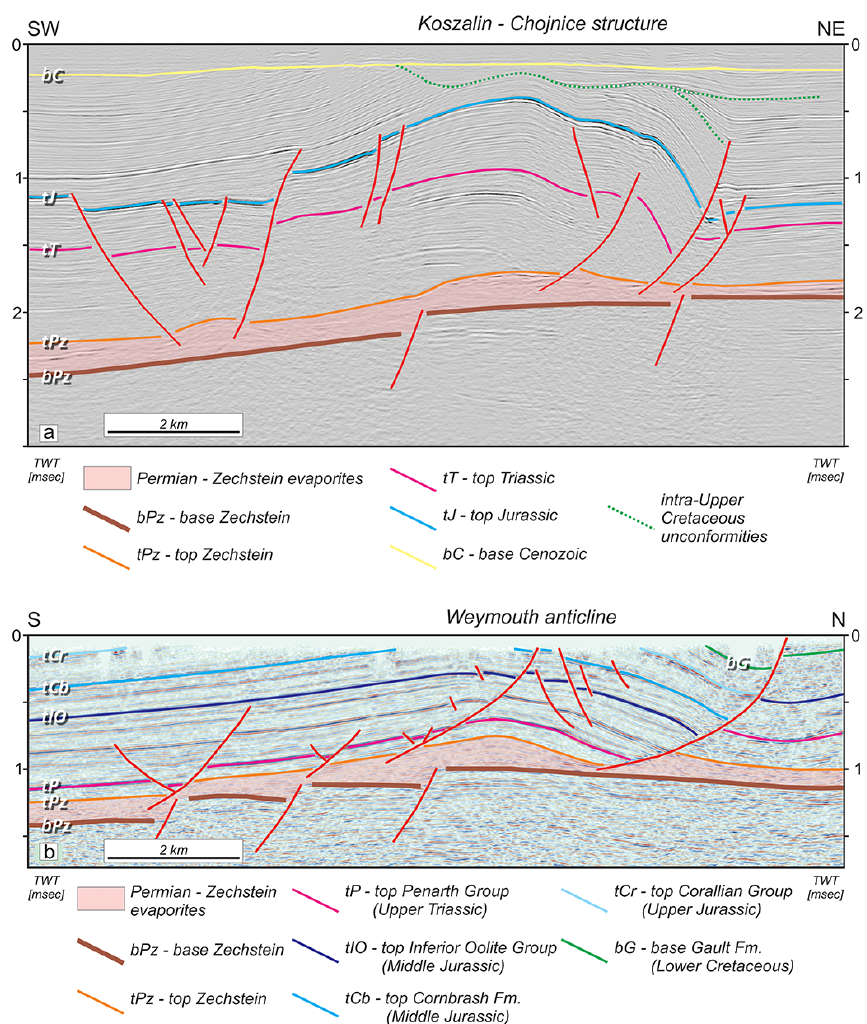
Figure 11. Thin-skinned inversion structures detached within the Zechstein evaporites: the Koszalin–Chojnice structure from NW Poland ( a ; cf. Krzywiec, 2006b, 2012) and the Weymouth anticline from the southern UK ( b ; based on Chadwick and Evans, 2005, partly reinterpreted). Both seismic lines are displayed with the same horizontal and vertical scale so certain structural features could be directly compared.